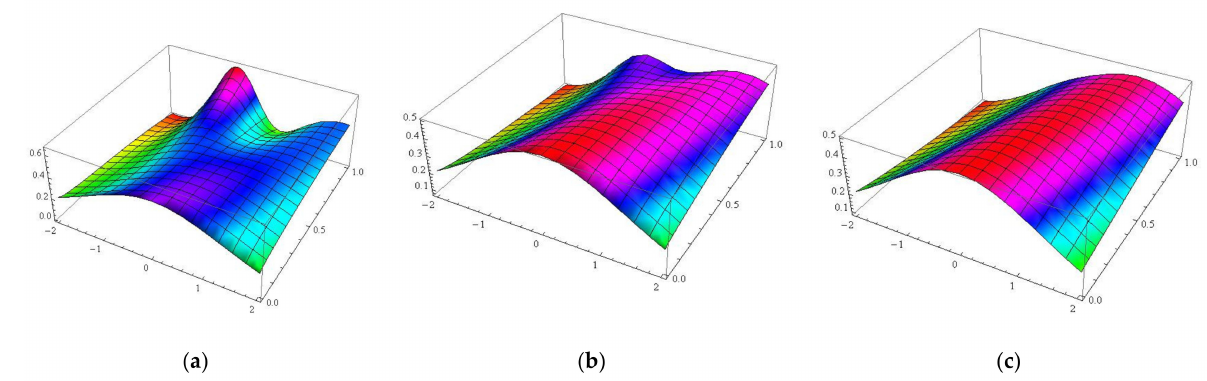
Figure 2. The surface graph of the 3D plots of the 5th-approximate L-RPS solution w 5 ( x , t ) in Equations (23) and (24) at: ( a ) β = 0.6 ( b ) β = 0.75 ( c ) β =